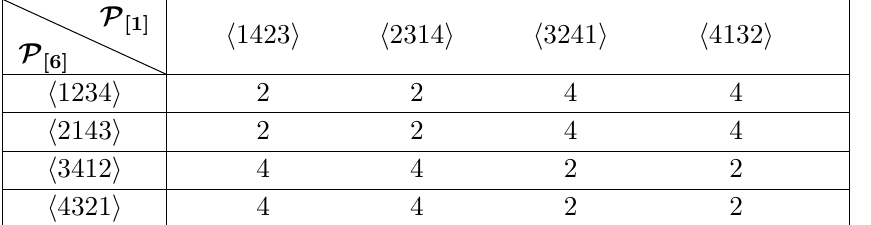
Table 7. {P} 6 − {P} 1 two-point correlator values.